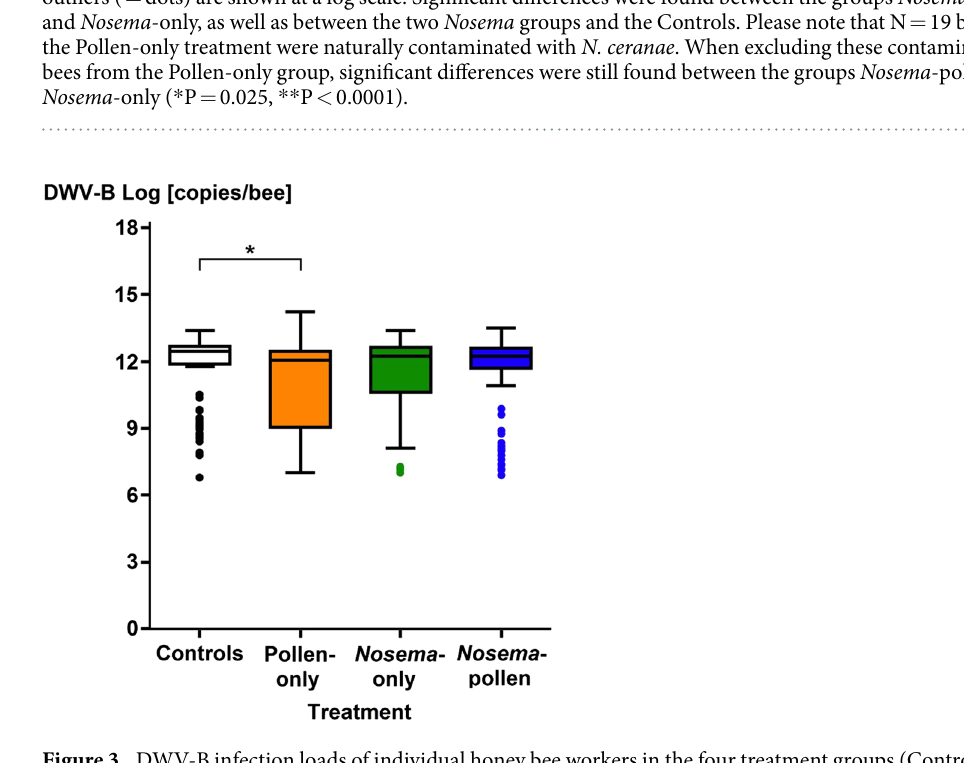
negative correlation was found between N. ceranae spore loads and DWV-B infection levels in the Nosema -pollen treatment (Pearson Correlation: Pearson |r| = − 0.34, P = 0.0035). The expected interaction of virus for com- bined agents was calculated between N. ceranae and DWV-B in the combined treatments ( Nosema -only and Nosema -pollen) and can be considered close to antagonistic due to the calculated negative value − 10.58 (equation-5) between the two pathogens ( χ 2 = 4.905 (equation-3), theoretical χ 2 = 3.841, df = 1, P = 0.05). However, the interactive effects of N. ceranae in the combined treatments (Pollen-only, Nosema -only and Nosema -pollen) is close to additive due to the calculated smaller χ 2 -value ( χ 2 = 0.025 (equation-3), theoretical χ 2 = 3.841, df = 1, P = 0.05).